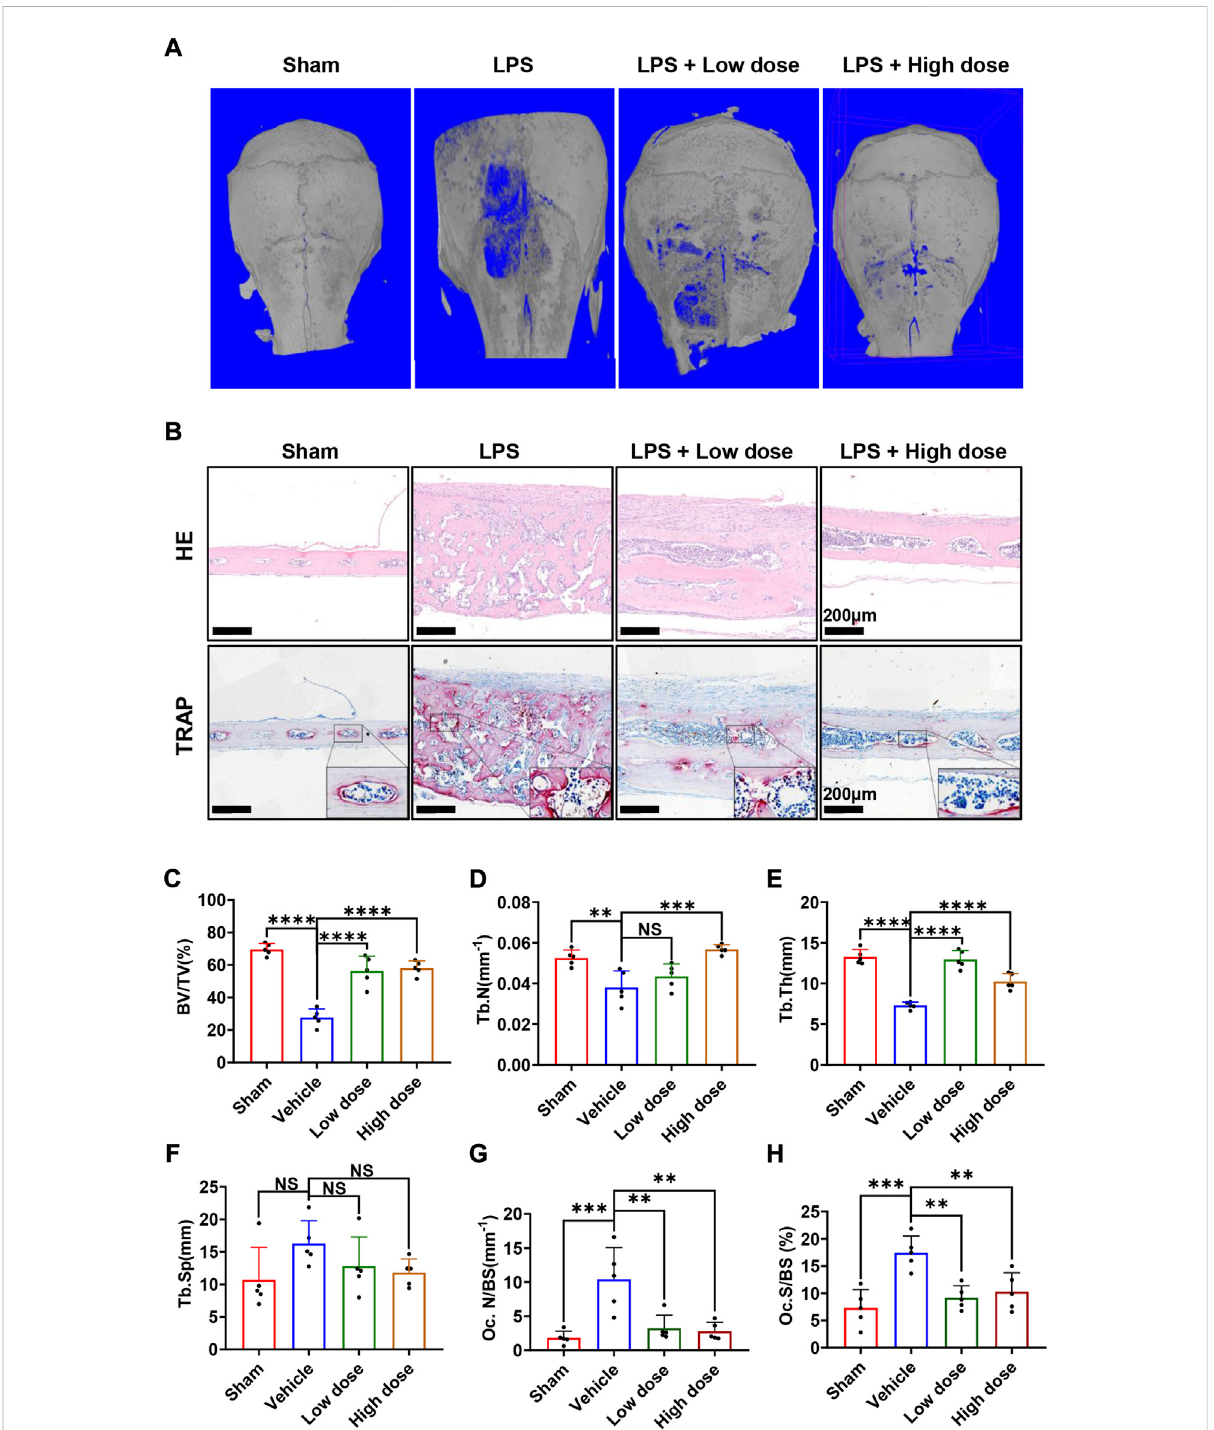
BNTA attenuated LPS-induced bone loss in murine calvaria. (A) Micro-CT and 3-dimensional reconstruction of murine calvaria from sham group (PBS), vehicle group (LPS 5 mg/kg body weight), low dose group (LPS 5 mg/kg and BNTA 0.15 mg/kg) and high dose group (LPS 5 mg/kg and BNTA1.5 mg/kg). (B) Representativeimagesofdecalci fi edbonesectionsstainedwithH&EandTRAPfromeachgroup. (C – H) Quantitativeanalysisof BV/TV,Tb.N,Tb.Th,Tb.sp,Oc.N/BSandOc.S/BSintissuesections.( n =5).Alldataarepresentedasmean±SD.** p < 0.01,*** p < 0.001**** p